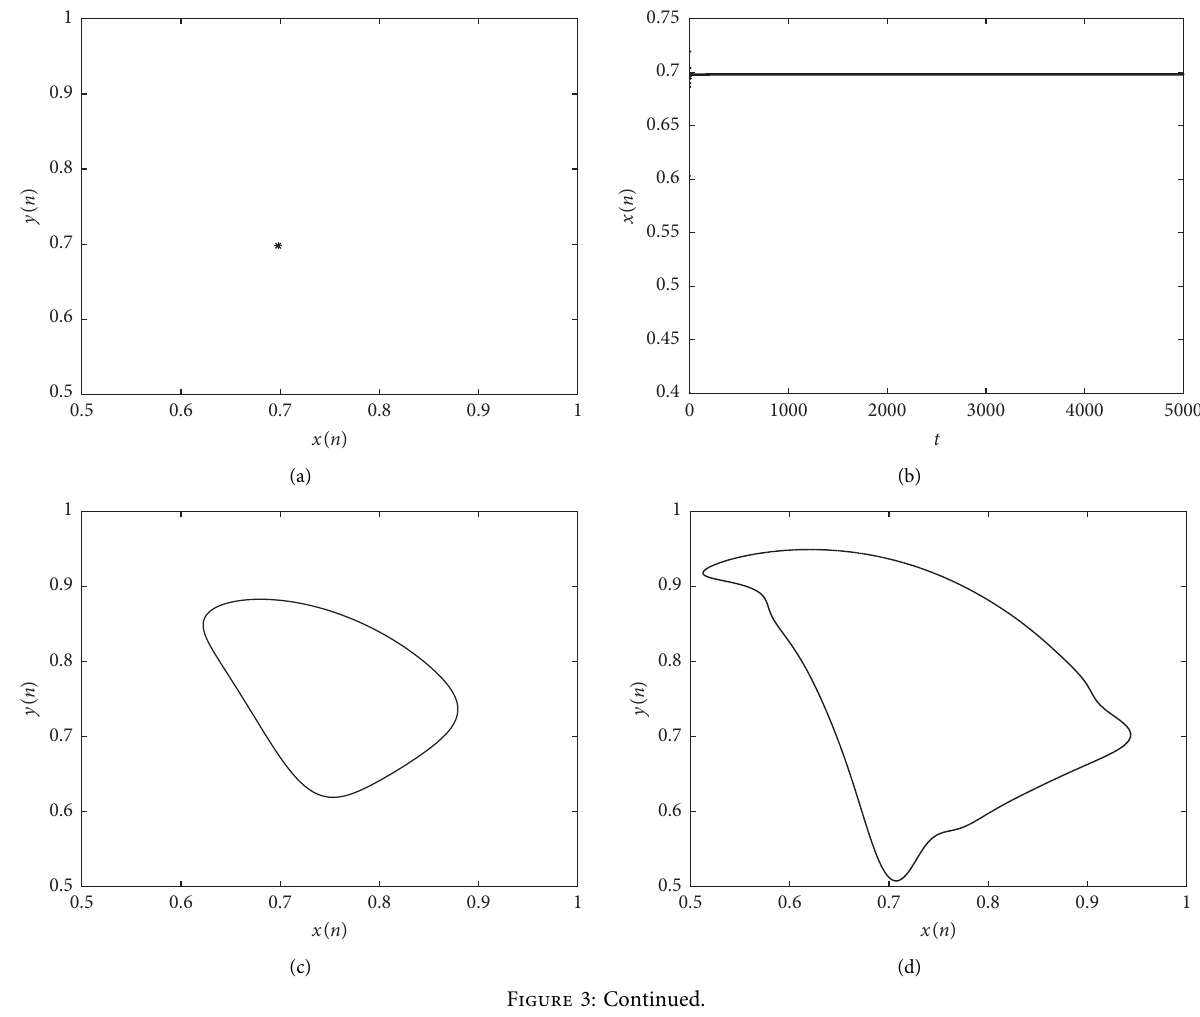
Figure 2: The phase diagrams of map (10) with the initial condition x with b � 1, (c) b � 1 . 5, (d) b � 1 . 6, (e) b � 1 . 7, (f) b � 1 . 75, (g) b � 1 . 9, (h) b � 1 . 95, (i) b � 2, and (j) b � 2 .